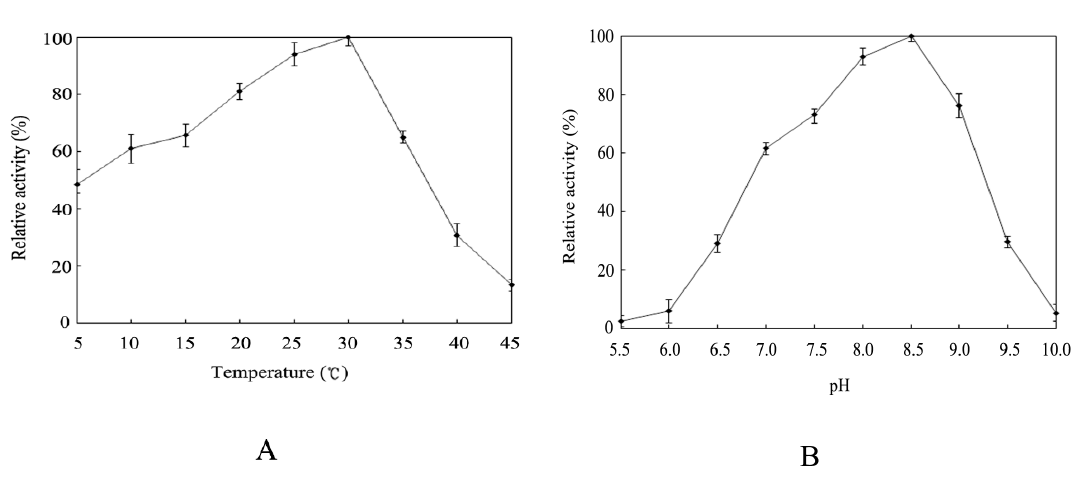
Figure 3. Temperature and pH optima of the nicotine hydroxylase HSPH ZZ . ( A ) Temperature optimum of HSPH ZZ was determined with HSP as substrates in 20 mM Tris-HCl buffer (pH 8.5) at temperatures ranging from 5 ◦ C to 45 ◦ C; ( B ) pH optimum of the enzyme at pHs ranging from 5.5 to 10 was measured for 30 min at 30 ◦ C. The buffers used were 20 mM of sodium acetate (pH 5.5 to 6.0), sodium phosphate (pH 6.5 to 7.5), Tris-HCl (pH 8.0 to 9.0), and N -cyclohexyl-3-aminopropanesulfonic acid (pH 9.5 to 10.0). Relative activity was calculated by defining original activity as 100%. The values are means of three independent experiments.